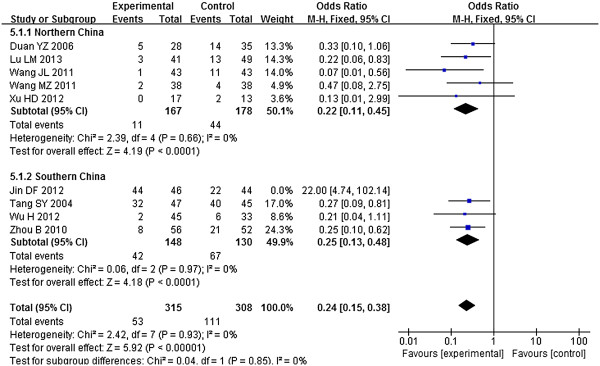
The forest plot of postoperative complication rate after sensitivity analysis.